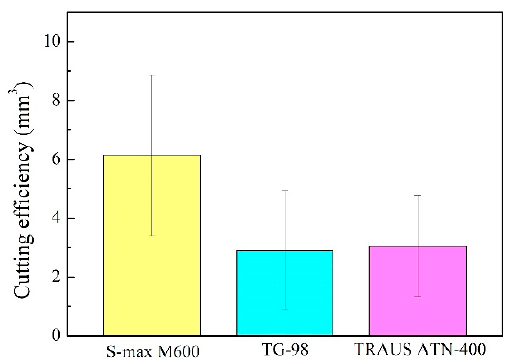
Figure 5. Cutting e ffi ciencies of the three kinds of high-speed Figure 5. Cutting efficiencies of the three kinds of high-speed handpieces. Figure 5. Cutting efficiencies of the three kinds of high-speed handpieces.